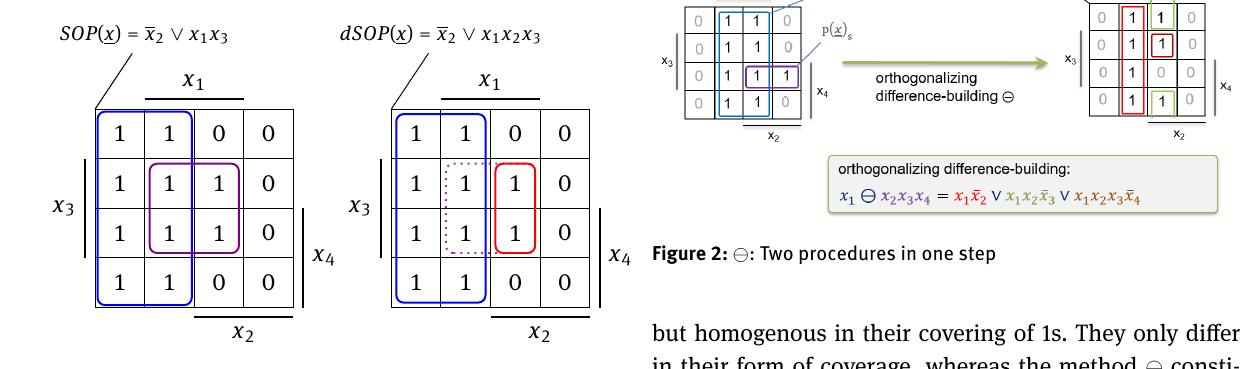
Figure 1: Difference between SOP and dSOP in a K-map